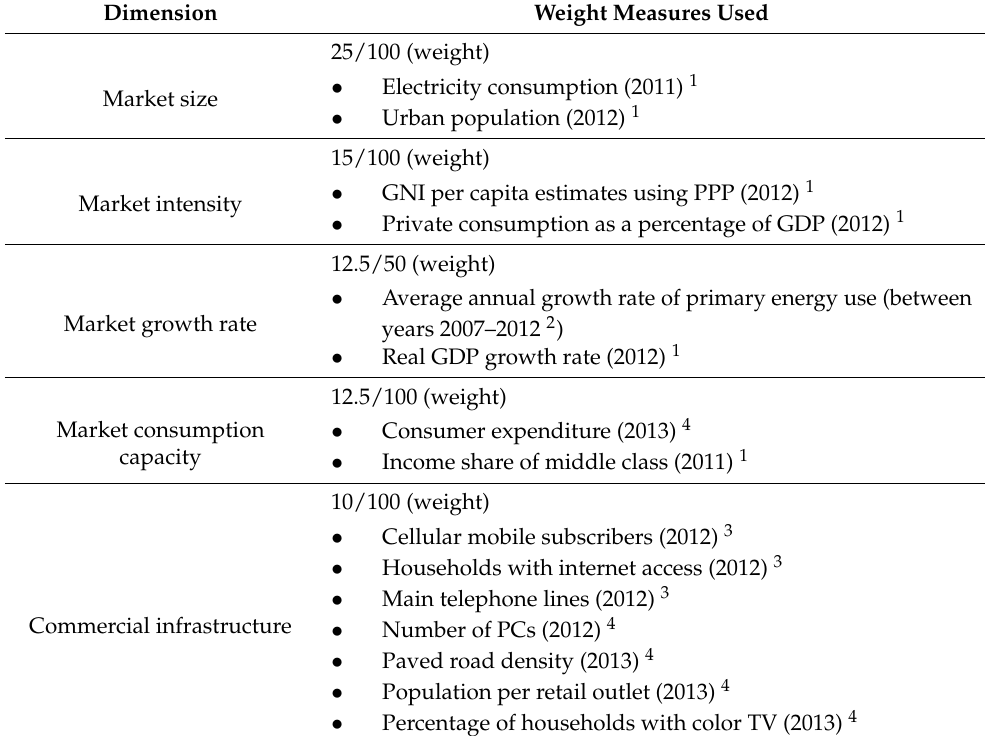
Table A1. Dimensions and measures of market potential